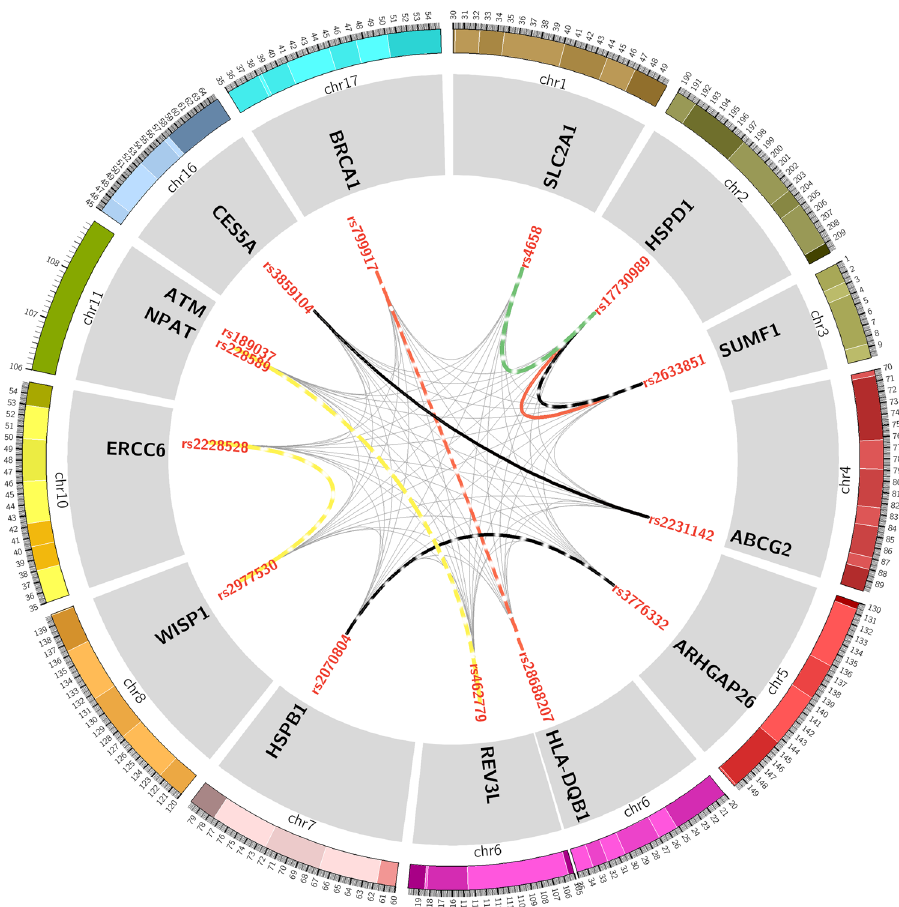
Figure 1. Paired gene-gene interaction in discovery stage, validation stage respectively. The chromosomes are arranged end by end in a clockwise direction. The exterior of the circle is chromosome number and scale. The inner circle represents the genes of SNPs located. The innermost circle is the name of SNPs. The lines connecting two SNPs represent paired gene-gene interactions. The thinner grey lines represent interactions with no statistical significance while thicker dotted line represent interactions with statistical significance in discovery stage and thicker solid line represent interactions replicated in the validation stage. Black lines represent overall toxicity, red lines hematologic toxicity, green line sensitivity and yellow lines gastrointestinal